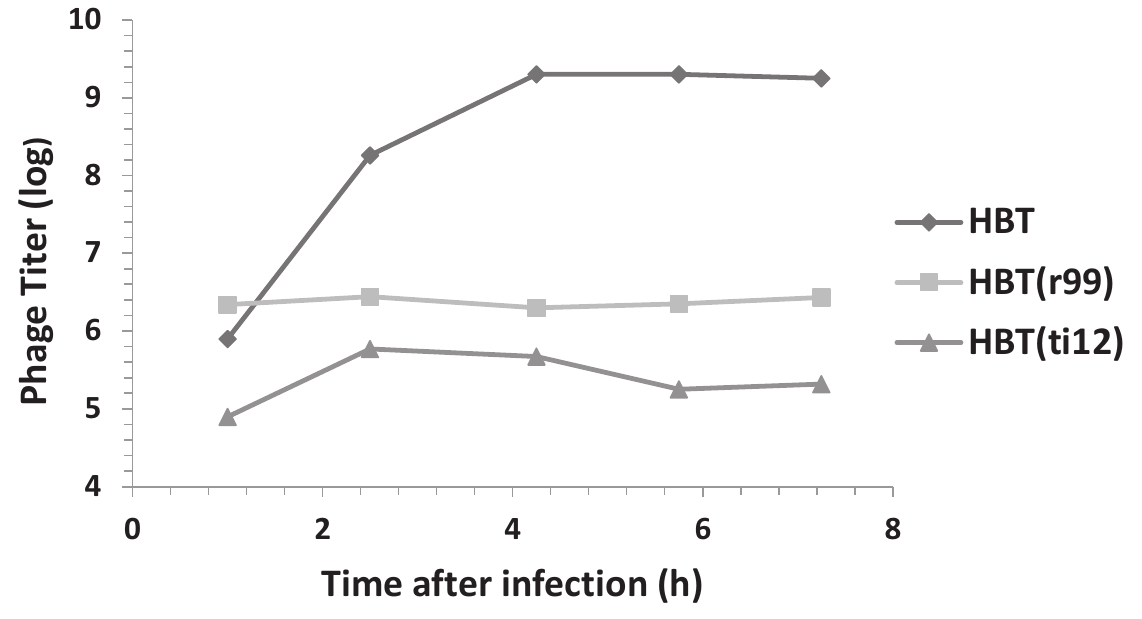
Figure 5. Phage titers following λ infection of HBT, and the HBT(pOri1) variants r99 and ti12. The phage titer from λ -infected cultures of HBT and HBT (pOri1) variants r99 and t1t12 were determined at indicated times after infection, as previously described. Titers expressed in a log